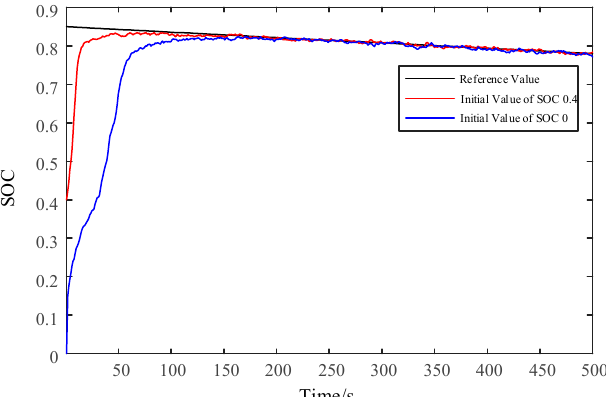
Figure 9. State of charge (SOC) estimation curve based on the fuzzy unscented Kalman filtering algorithm (F-UKF) under discharge conditions with constant-current pulses.